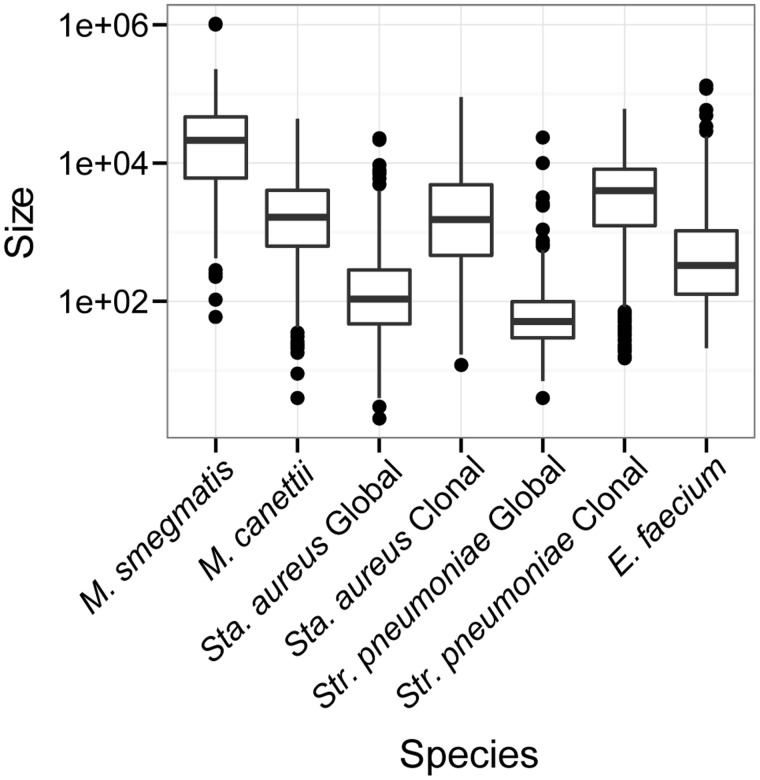
Size distributions of recombinant fragments. Boxplot of LGT fragment sizes in several species of bacteria. LGT fragments identified using BRATNextGen except for M. smegmatis, which shows the size distribution of recombinant fragments identified by Gray et al. (2013). Recombinant fragments identified with BRATNextGen were combined if the gap between them was less than 475 bp (supplementary figs. S2 and S3, Supplementary Material online). Size shown in base pairs on the y axis is on a log scale. We observed an effect of sampling on the size distribution of LGT fragments: Fragment sizes were smaller in diverse samples of Sta. aureus and Str. pneumoniae relative to samples taken from a single lineage. LGT fragments in the diverse sample of M. canettii are larger than those found in comparable samples of other bacteria. Samples of M. smegmatis were taken immediately after experimental mating: We hypothesize that in natural populations the large LGT fragments observed here would be interrupted (and shortened) by subsequent mutation and LGT.